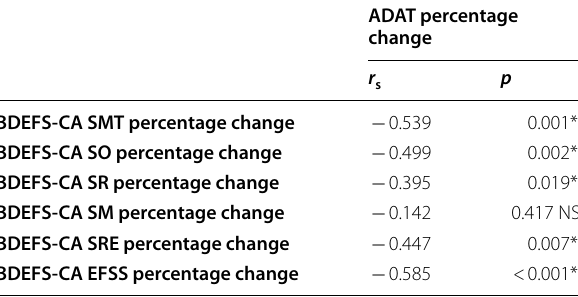
r , Pearson coefficient. *Statistically significant at p < 0.05. **Statistically highly significant at p <